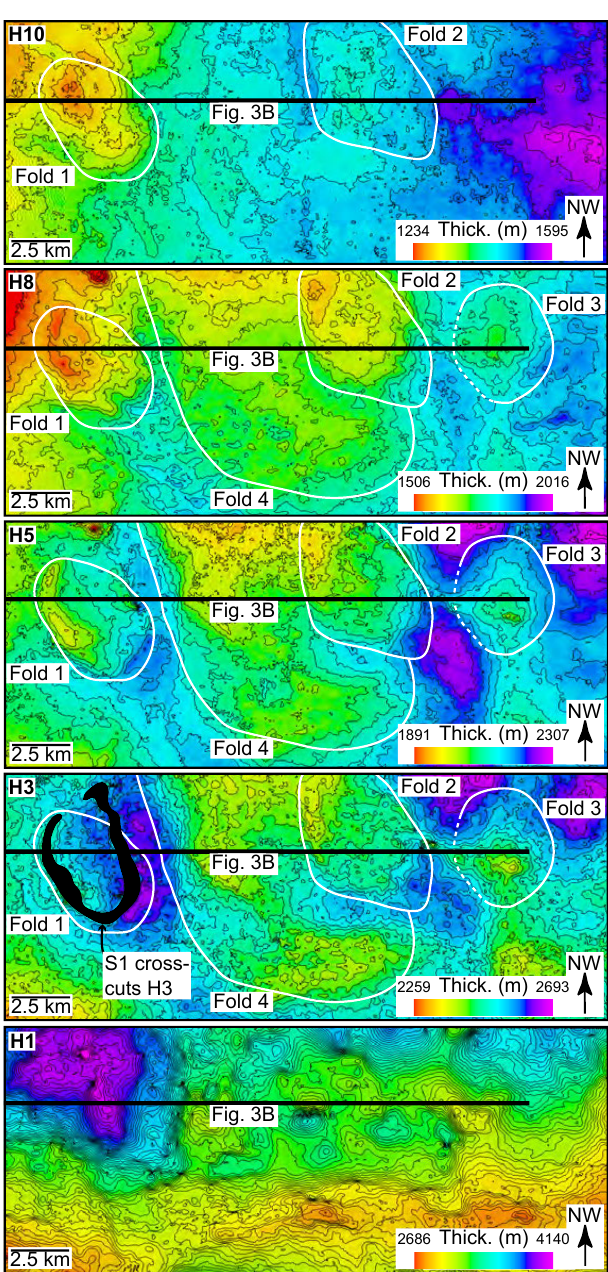
Figure 8: Depth-structure maps for H1, H3, H5, H8, and